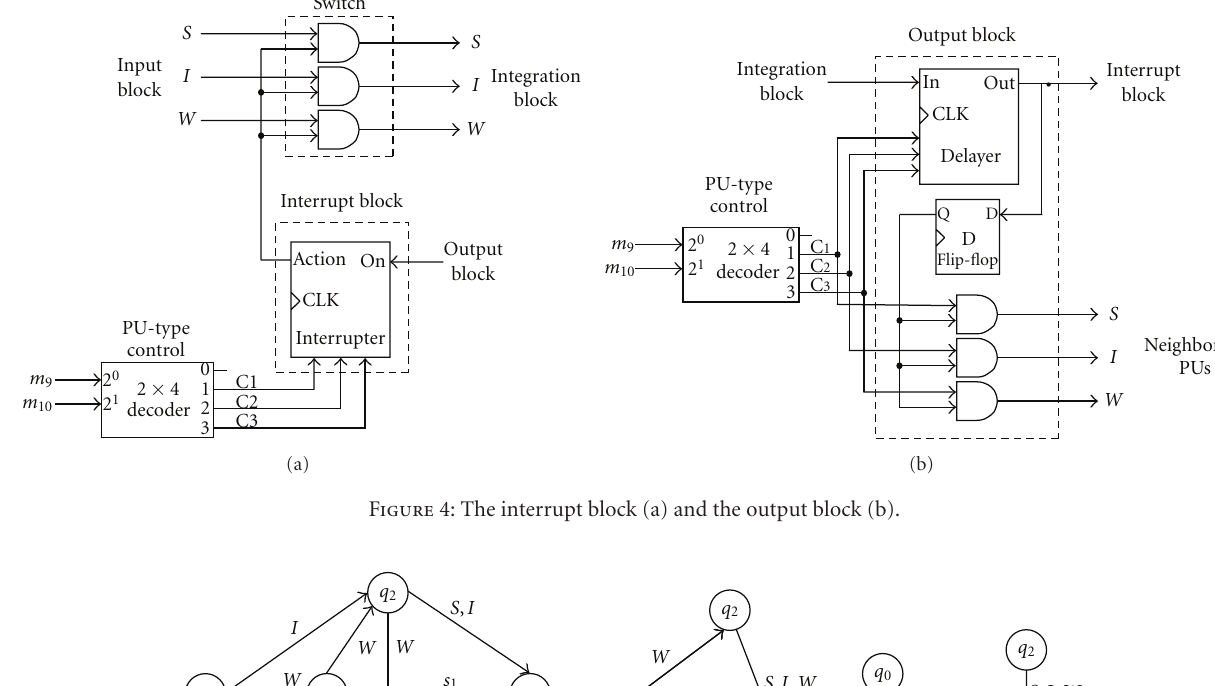
Figure 4: The interrupt block (a) and the output block (b).